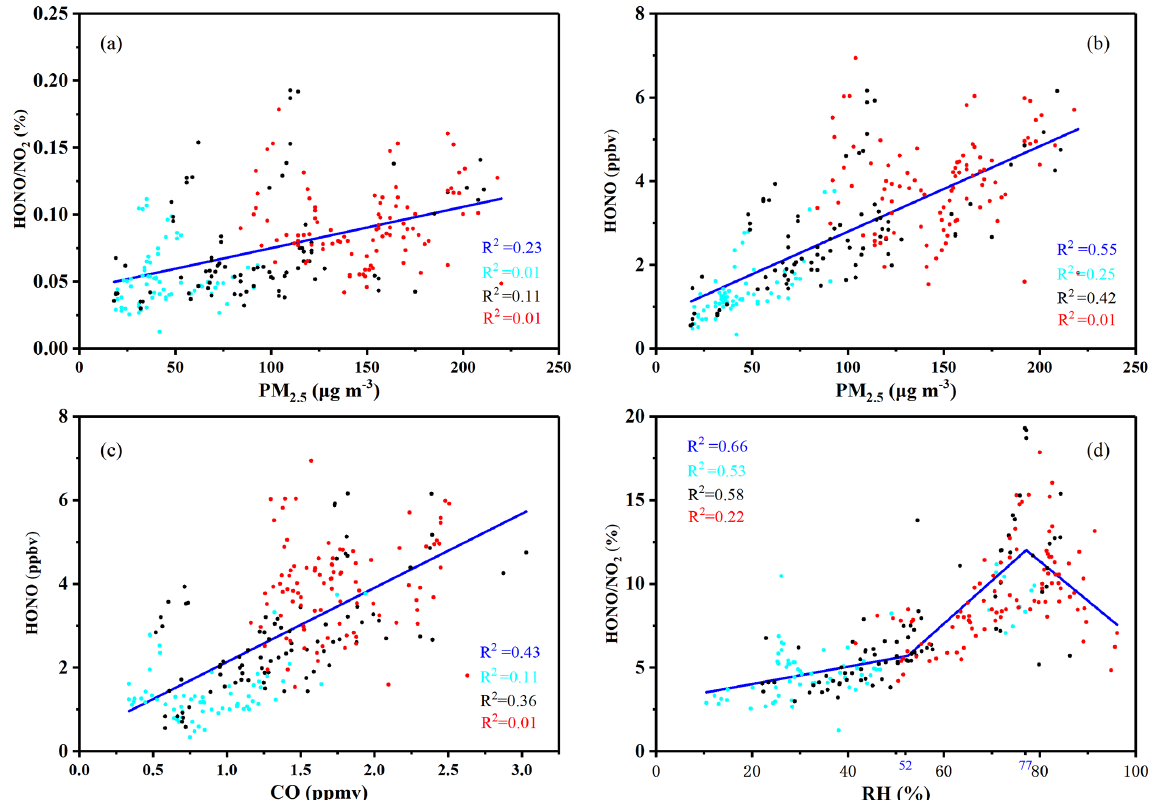
Figure 7. Nighttime correlation studies between PM 2 . 5 and HONO / NO 2 ; PM 2 . 5 and HONO; CO and HONO; and RH and HONO / NO 2 during the entire measurement period – including the CD, PD, and SPD periods. The blue lines represent the full measurement period; the light blue points represent the CDs period; the black points represent the PDs period; and the red points represent the SPDs